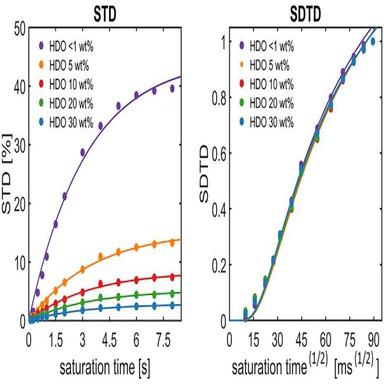
STD (left) and SDTD (right) build–up curves for HDO binding to OCNF 1 wt% dispersion acquired at different H2O/D2O ratios. The H2O concentrations used go from < 0.1 wt% (purple), 5 wt% (yellow), 10 wt% (red), 20 wt% (green) and 30 wt% (light blue). A b value of 1 was used. (For interpretation of the references to colour in this figure legend, the reader is referred to the web version of this article.)